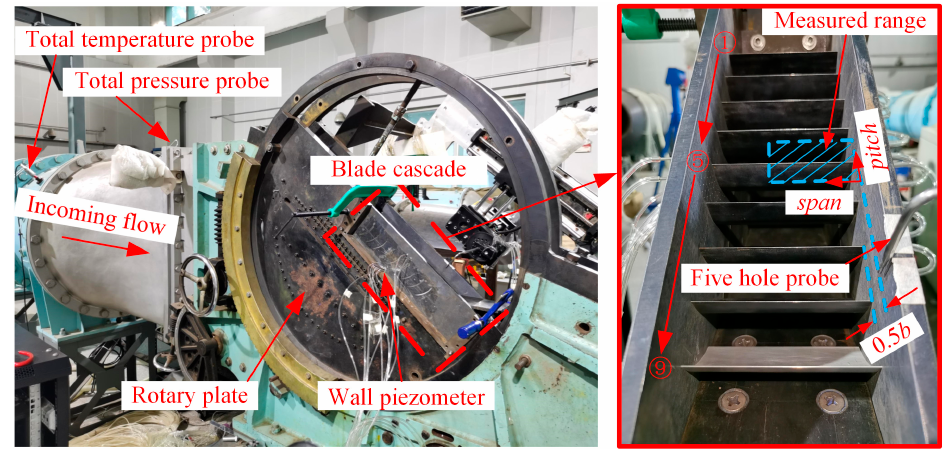
Figure 5. High-speed linear cascade wind tunnel.